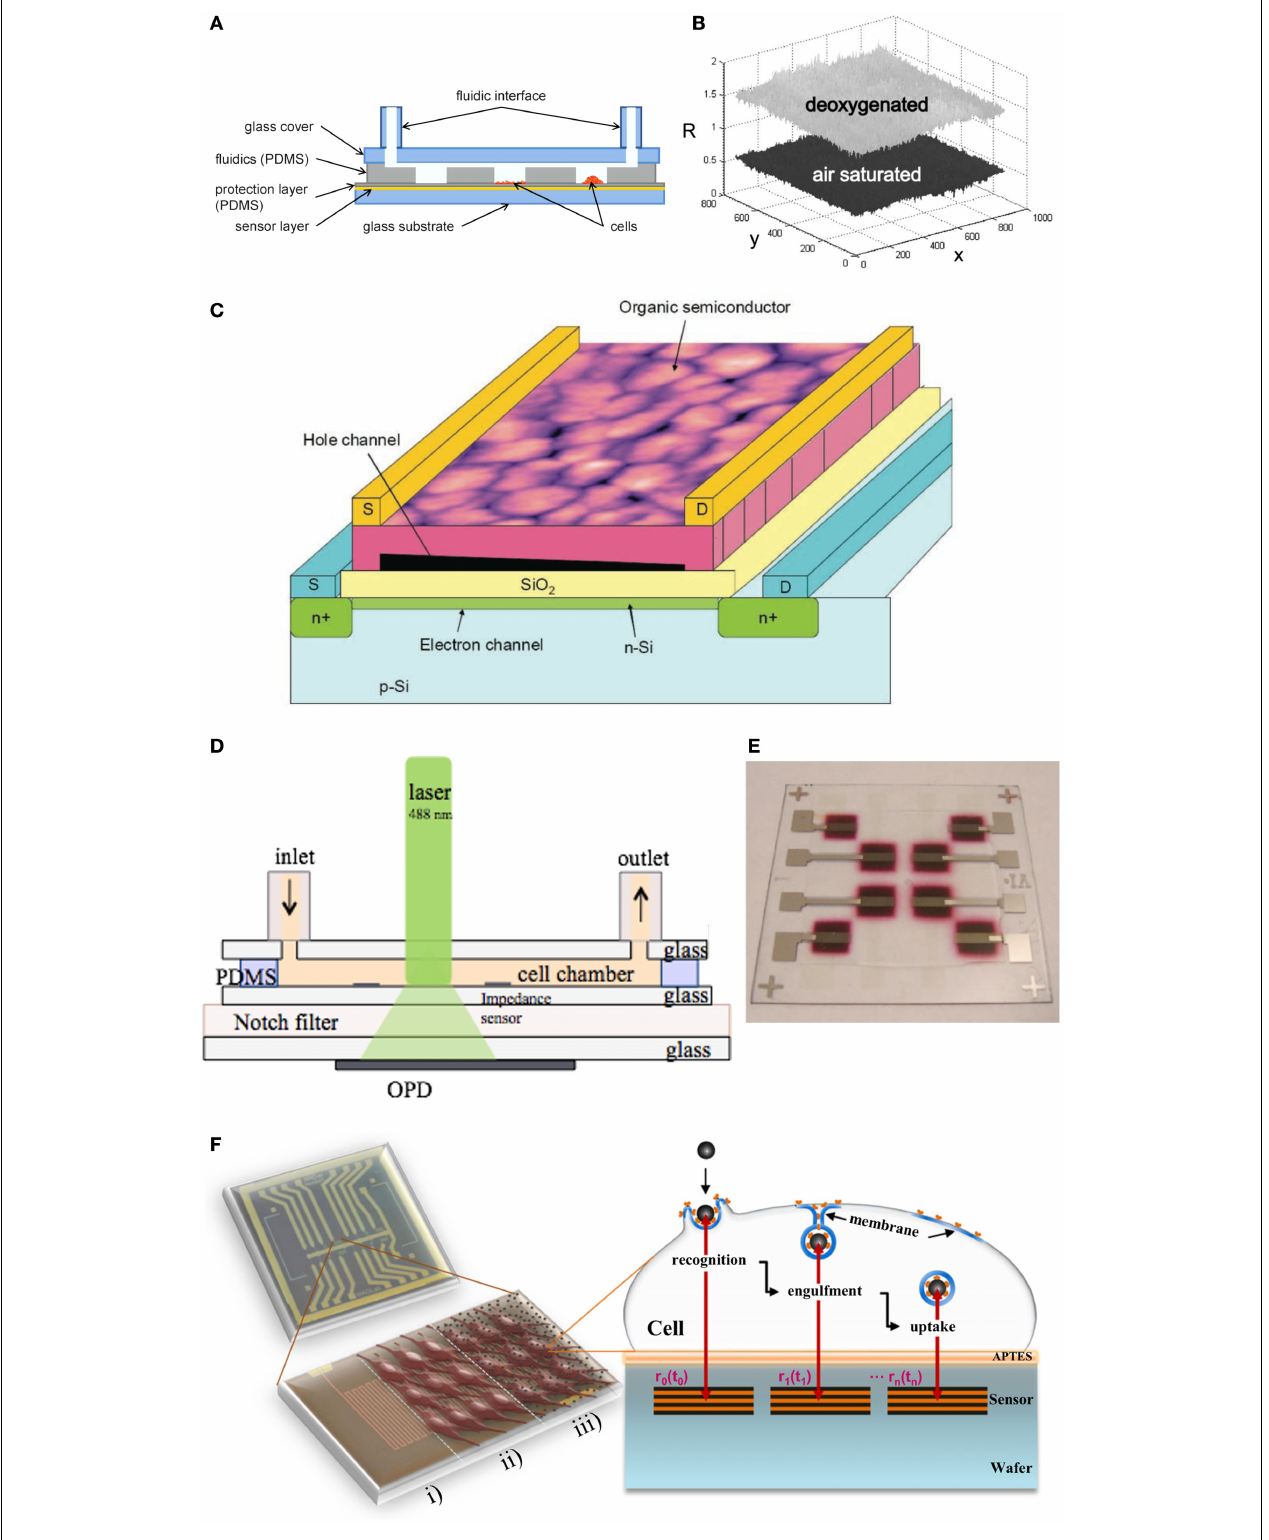
FIGURE 3 | Different integrable biosensors for cell culture analysis